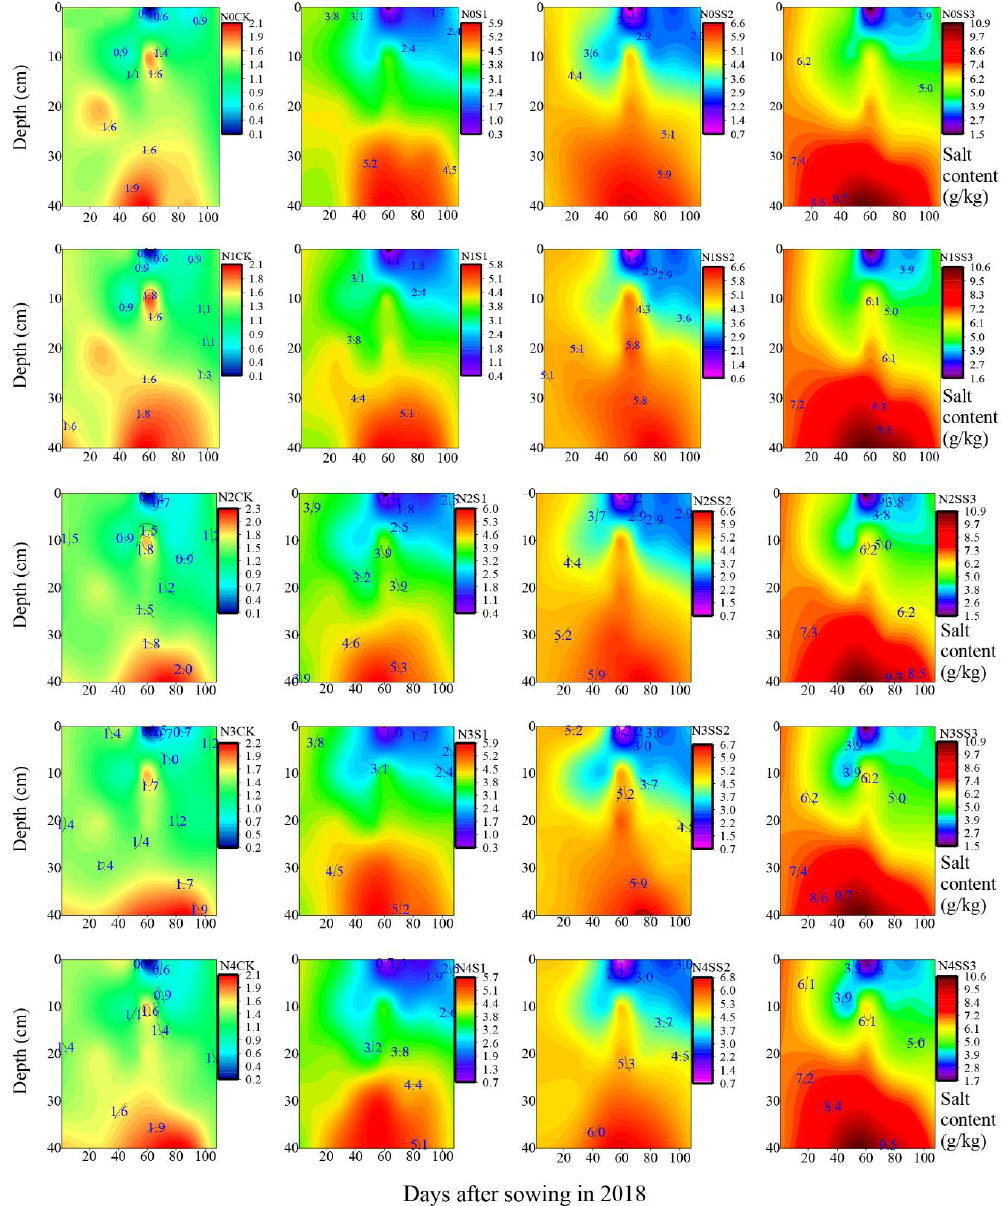
Figure 4. Dynamic distribution characteristics of salinity along the soil profile on different days after sowing in each treatment in 2018. From left to right, the application rate of salt increases. From up to down, the application rate of nitrogen increases.